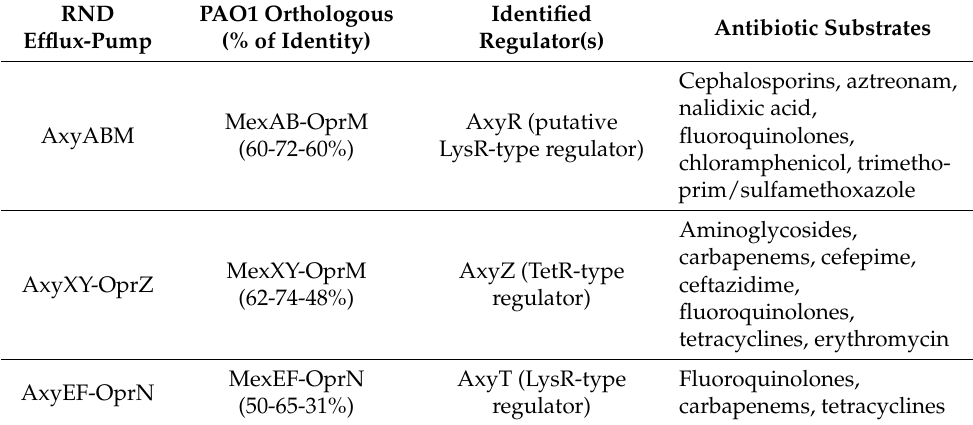
Table 3. Characterized RND efflux pumps in A. xylosoxidans